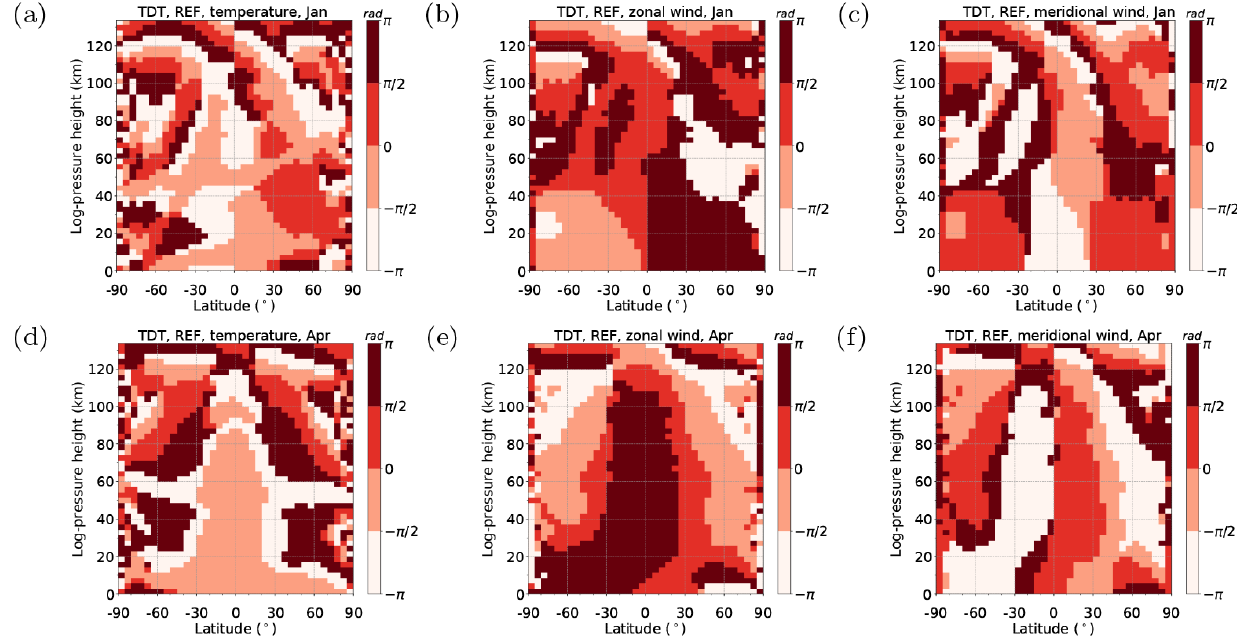
Figure 6. Zonal mean TDT phases (REF). (a, d) Temperature, (b, e) zonal wind, (c, f) meridional wind. (a–c) Solstice (January) conditions. (d–f) Equinox (April) conditions.